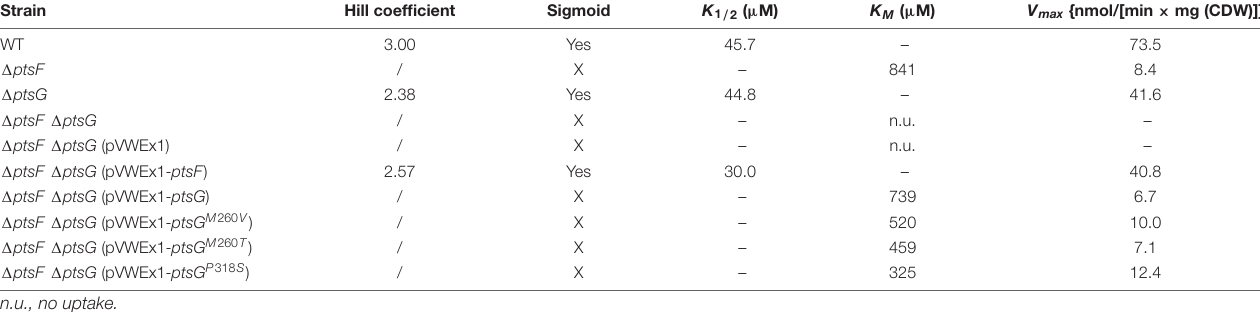
TABLE 4 | Kinetics parameters of fructose uptake by PtsF and PtsG. Strain